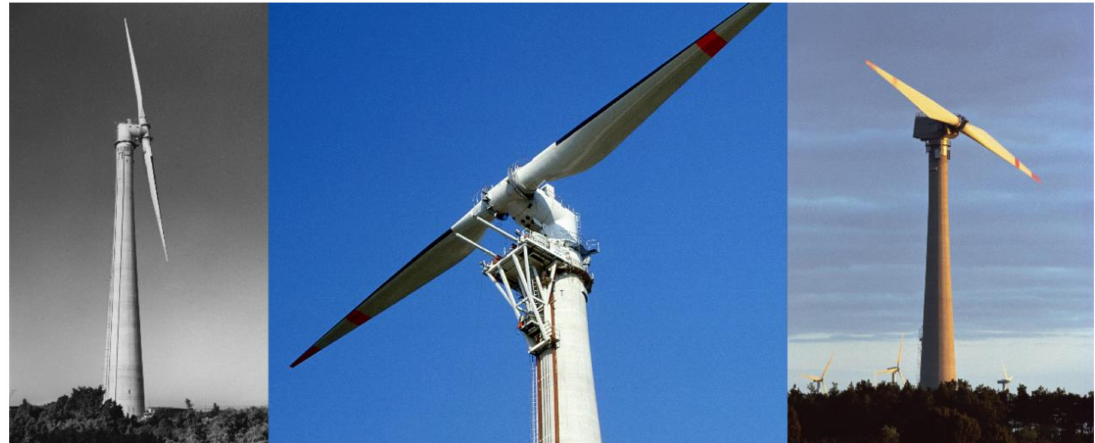
Figure 2. The Näsudden turbines. Left and center: The 2-MW Näsudden I (WTS-75) at Näsudden, Gotland. Photo used with permission from Vattenfall (left) and Jos Beurskens (center, all rights reserved). Note the lift platform that was used for erecting the nacelle, and thereafter the blades, during assembly. Right: The 3-MW Näsudden II at Näsudden, Gotland. Photo by and used with permission from Gunnar